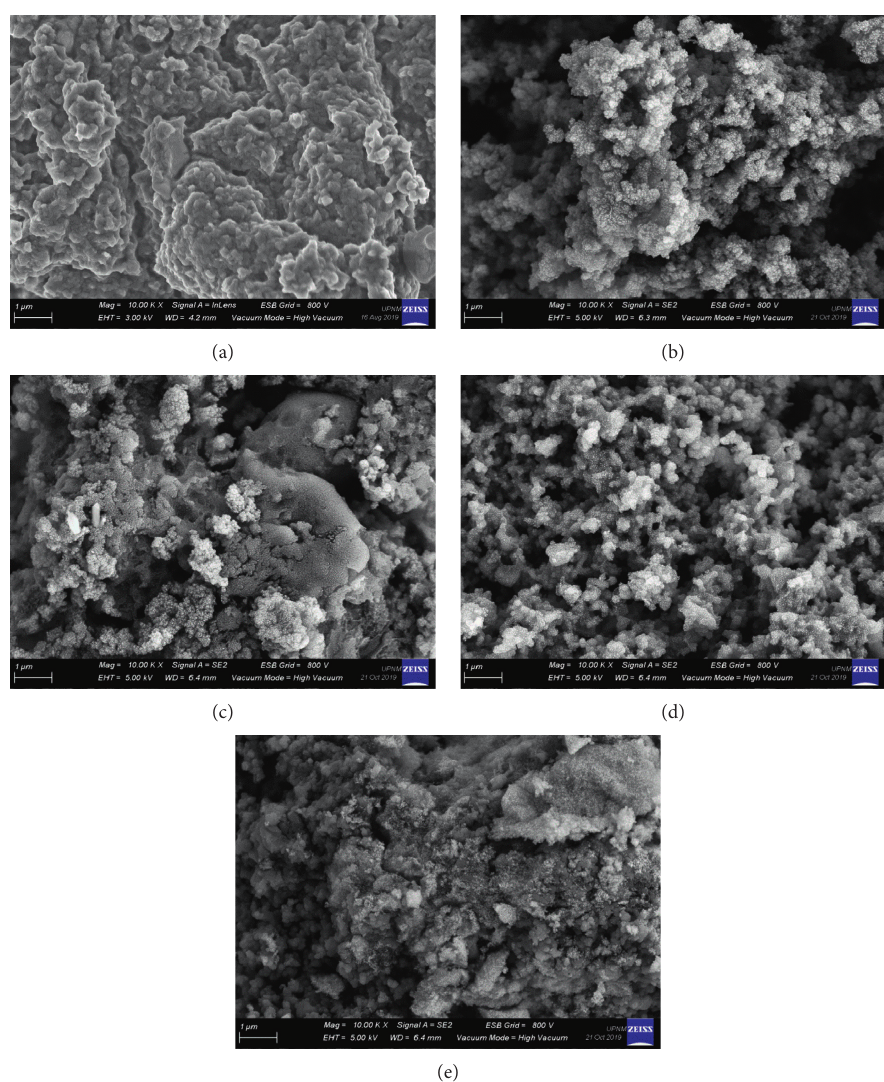
Figure 7: FESEM images with no sonication (a), one-hour sonication (b), three-hour sonication (c), 5 wt% PFFs (d), and 10 wt% PFFs (e).